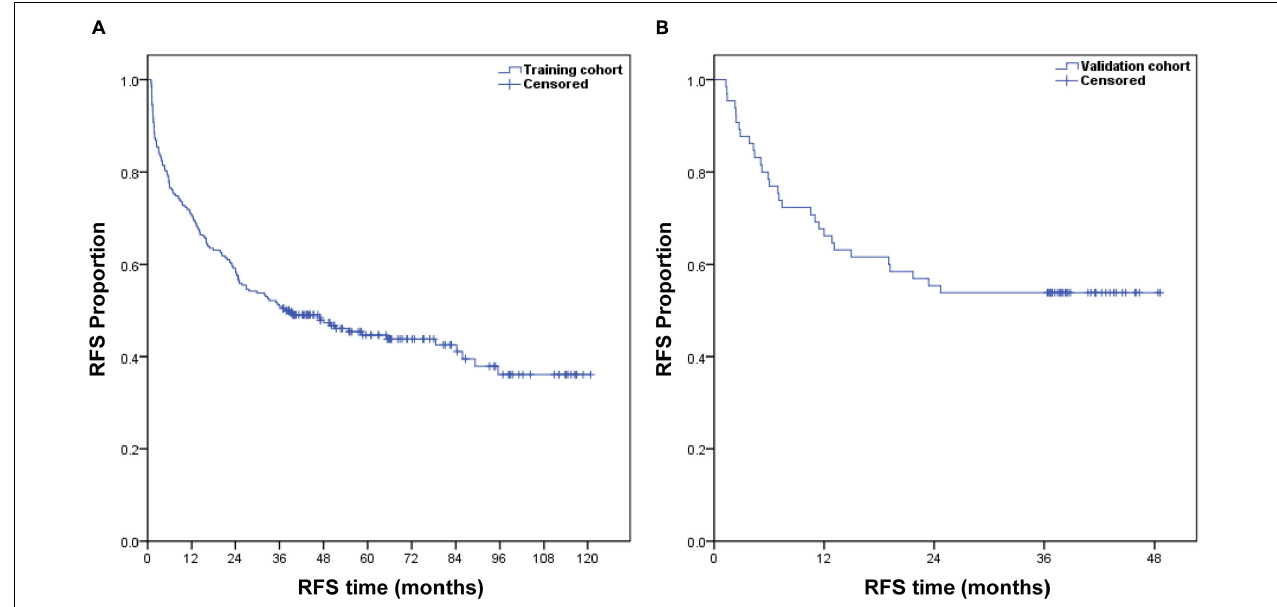
FIGURE 1 | Kaplan–Meier estimate of the postoperative RFS of patients with HCC in the training cohort (A) and validation cohort (B) .